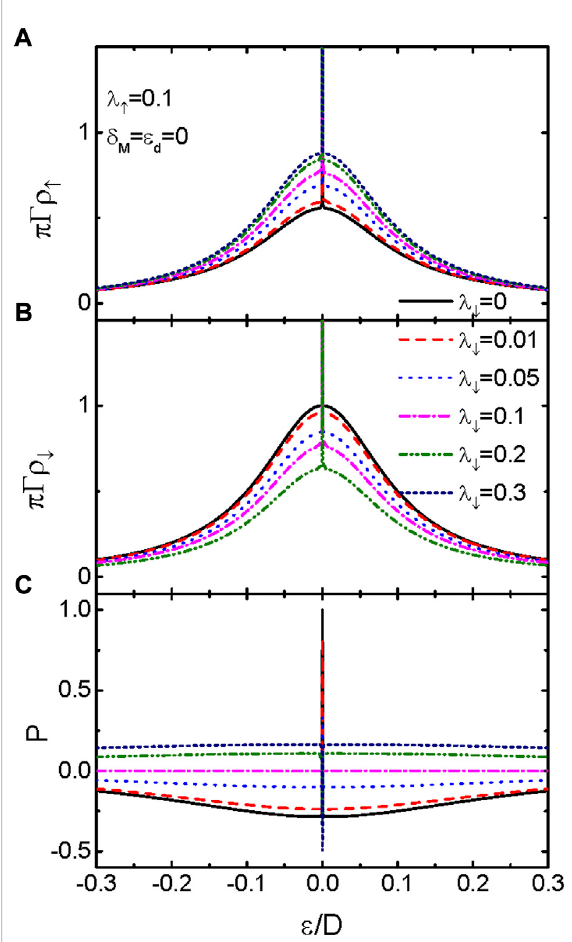
FIGURE 1 (Coloronline)Spin-up (A) andspin-down (B) LDOSvaryingas functions of electron energy for different values of λ ↓ . (C) is for the spinpolarizationoftheLDOS.Otherparametersare U =0, λ ↑ =0.1, dot level ε d = 0, and MBS – MBS interaction strength δ M = 0. With increasing λ ↓ , the magnitude of ρ ↑ (A) and ρ ↓ (B) is individually enhanced and suppressed. As a result, the spin polarization of the LDOS (C) fi rst decreases, changing its sign, and then